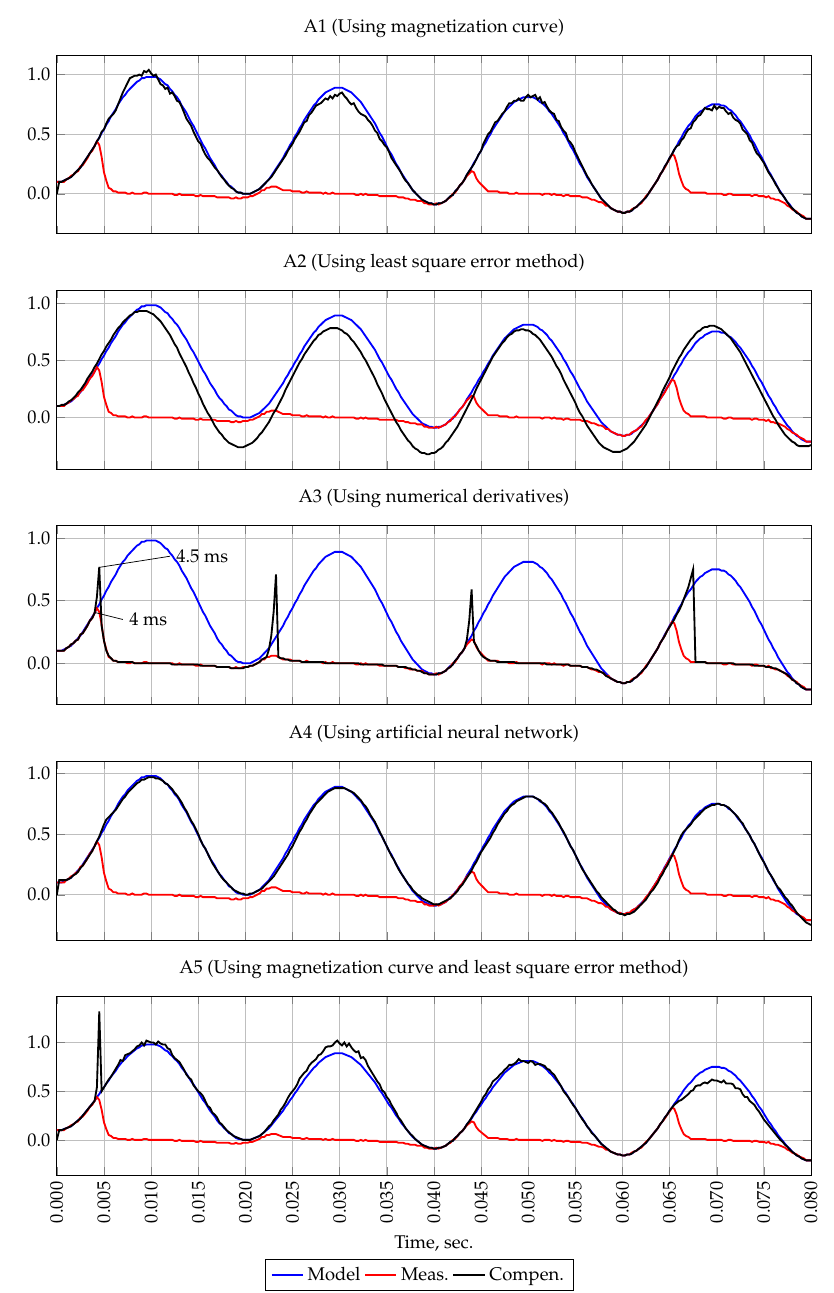
Figure 6. Oscillogram of currents, experiment 3